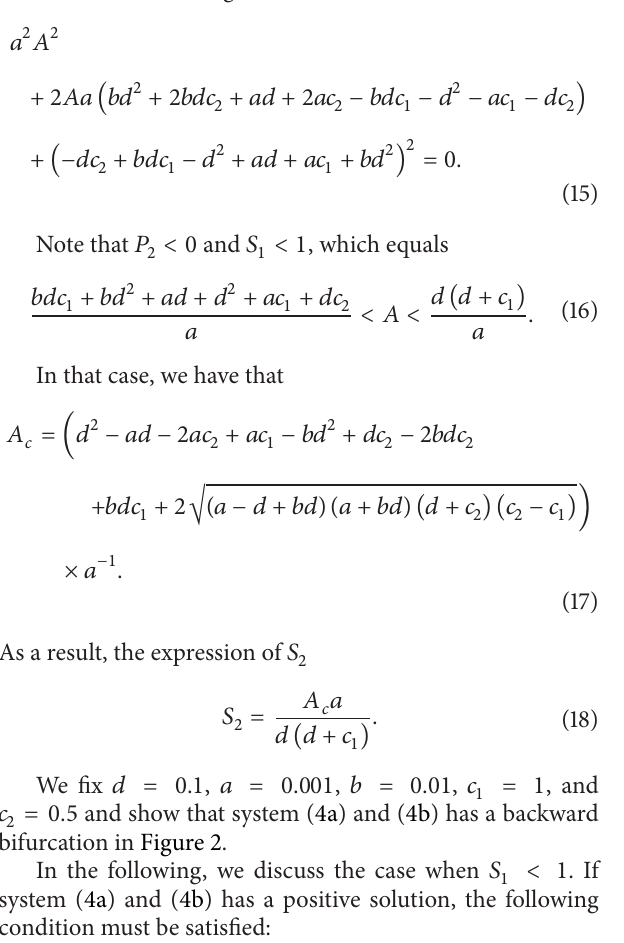
= 1 , and 𝑐 = 0.5 (color 1 2